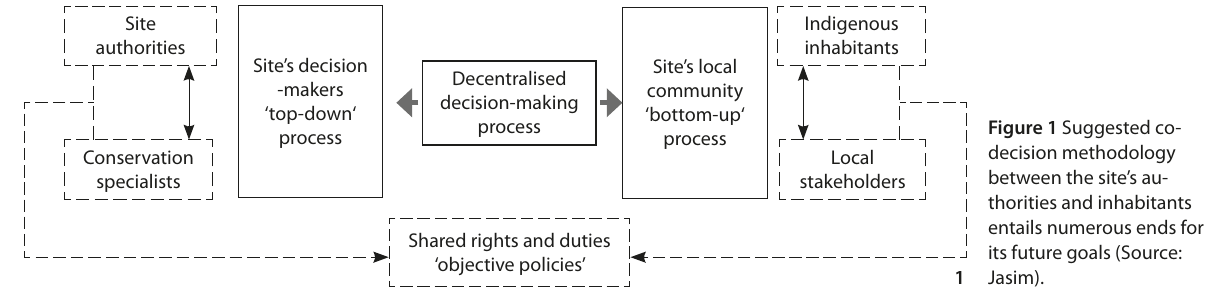
Figure 1 Suggested co- decision methodology between the site’s au- thorities and inhabitants entails numerous ends for its future goals (Source: